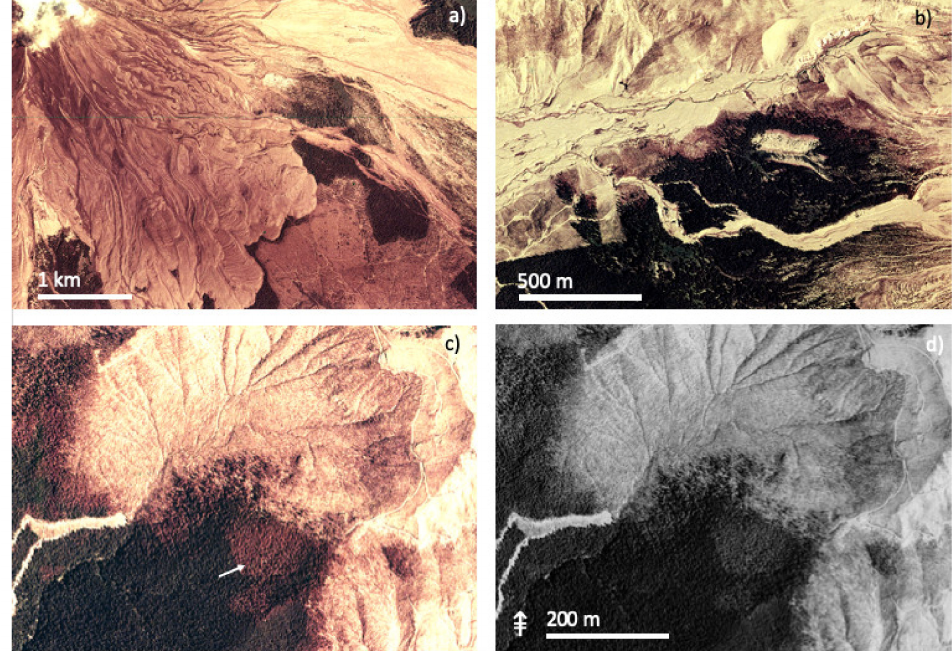
Figure 8. Mount St. Helens, Washington, USA. Lava lobes in ( a ), (near-infrared) lava streams cutting through the forest in ( b ), burnt forest in infrared in ( c ) and in ( d ) converted to greyscale for comparison. (Data: Table